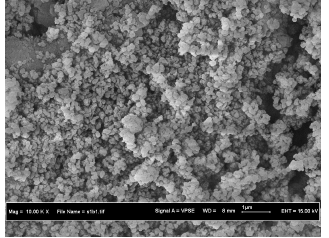
Figure 2 . SEM Micrograph of TiO 2 immobilised on ceramic tile